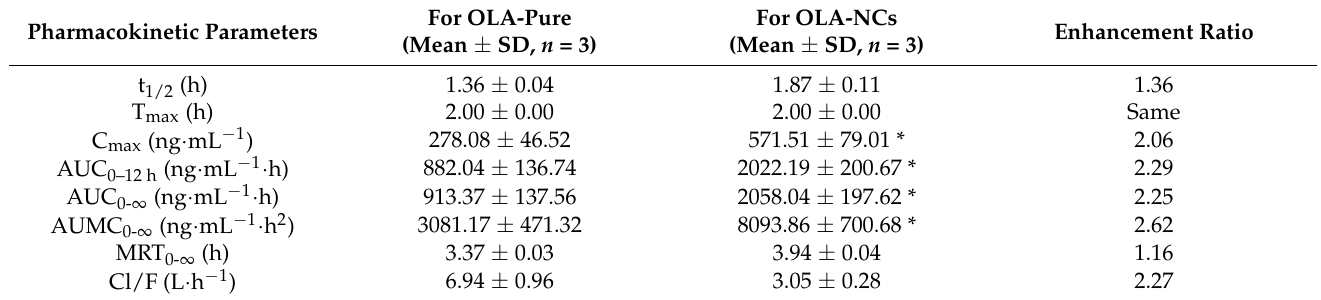
Figure 10. The drug concentration-time profiles of plasma samples oral administration of OLA-pure (conventional AqS) and OLA-NCs-2 in rats. Data are the mean of three samples (three animals per group) with standard error of mean (Mean ± SEM, n = 3). * ( p < 0.005) OLA-NCs-2 vs. conventional AqS of OLA-pure. Table 5. Oral pharmacokinetic of OLA-formulations. The data were represented as mean of three readings with standard error of mean (Mean ± SEM, n = 3), where * ( p < 0.005) represents the significant difference between NC 1 as compared to conventional